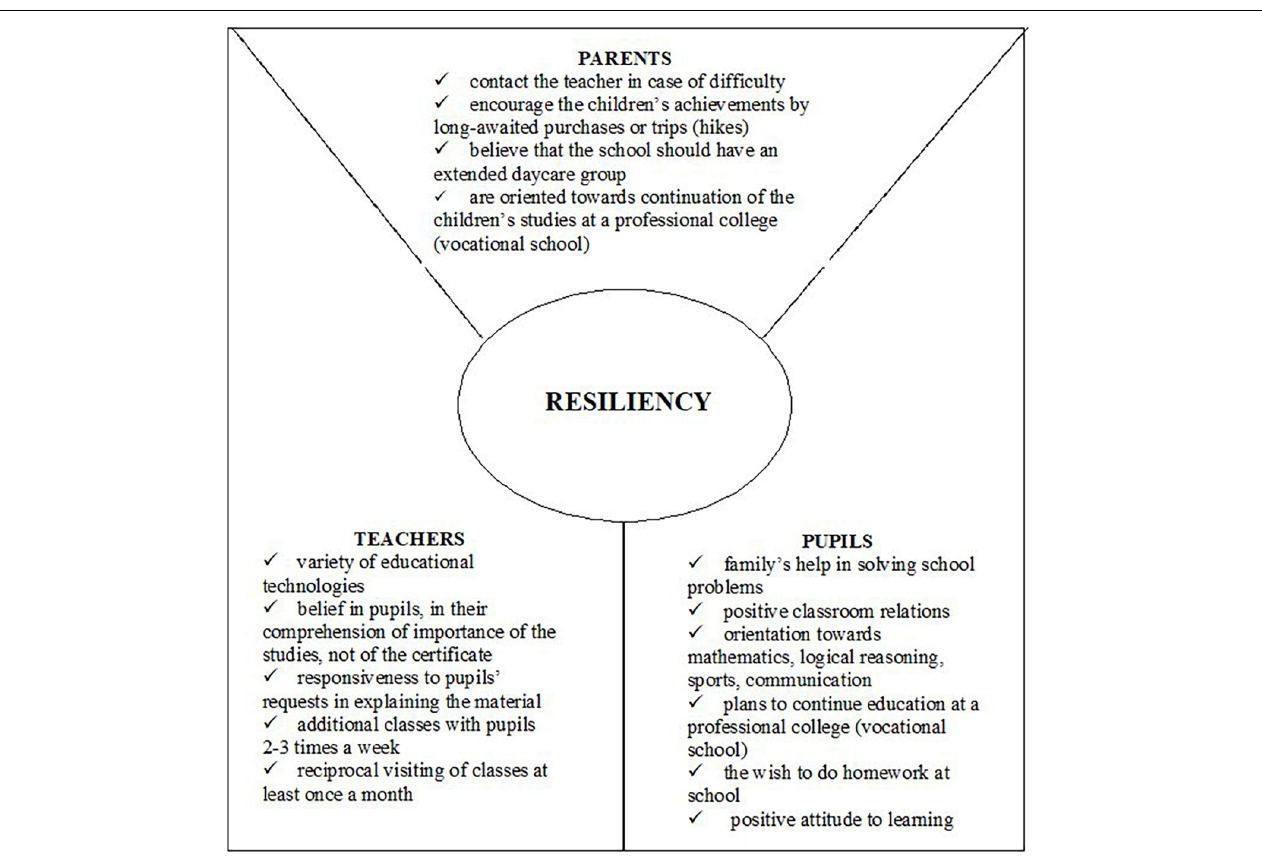
FIGURE 2 | General school-specific characteristics influencing